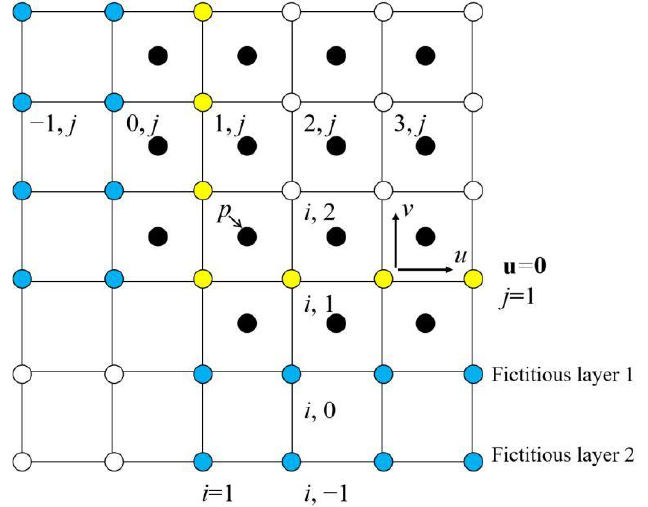
Figure 2. A half-staggered grid (only a corner shown herein) with two layers of ghost points. The circle in yellow denotes the boundary where the no slip condition is imposed, the circle in blue signals the ghost points and the circle in black stores the value of pressure. The points are indexed from i = 1 in the x direction and j = 1 in the y direction.